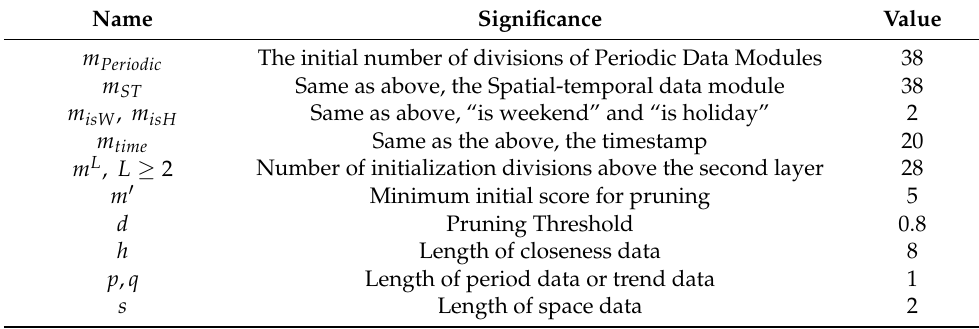
Table 3. Parameters settings of SCDFNN on the BikeNYC